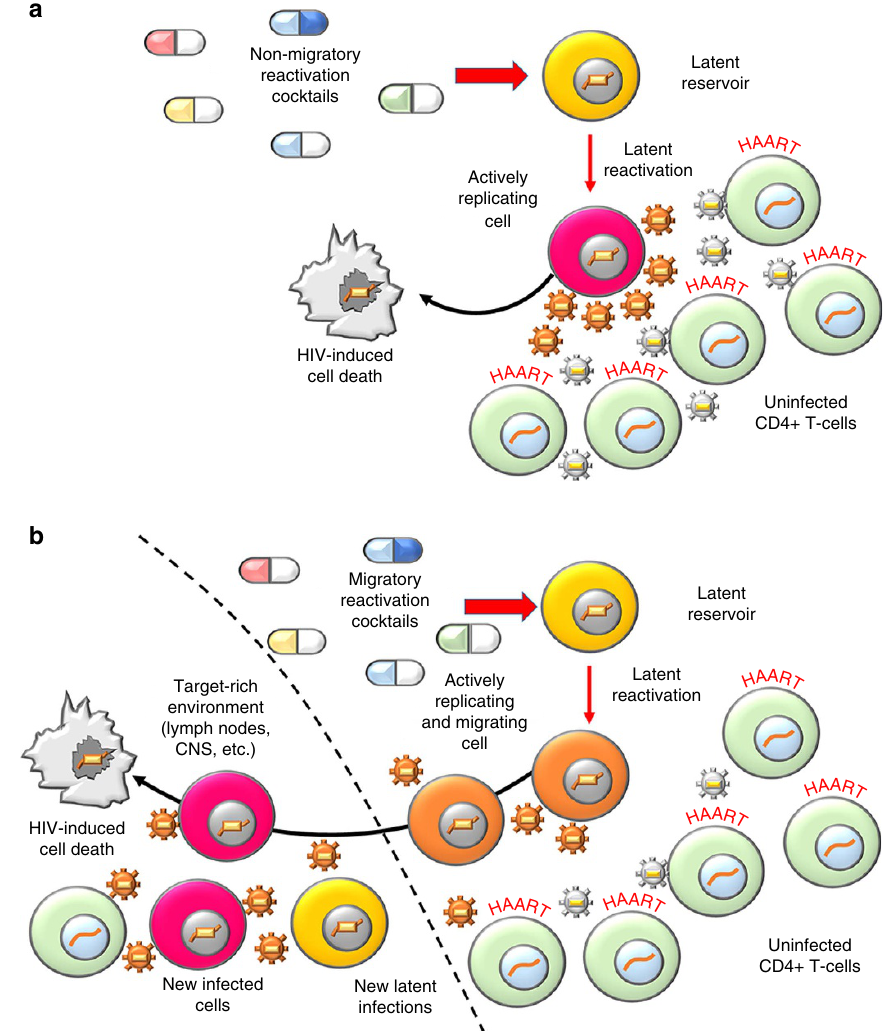
Figure 3 | Migration challenges elimination of latent HIV reservoirs with drug treatments. ( a ) An ideal non-migratory reactivation cocktail leads to active replication of latent cells and production of virus in a HAART-treated environment. Reactivated cells die without significant migration and the latent reservoir is cleared 16 . Bystander cells are protected by HAART from newly produced virus. ( b ) Migratory reactivation cocktails induce active replication and migration of latently infected cells. Migrating cells shed virus before cell death. Reactivated cells can reach target-rich cell niches high in CXCL12 ligand and unexposed to HAART, allowing new active and latent infections to occur 38